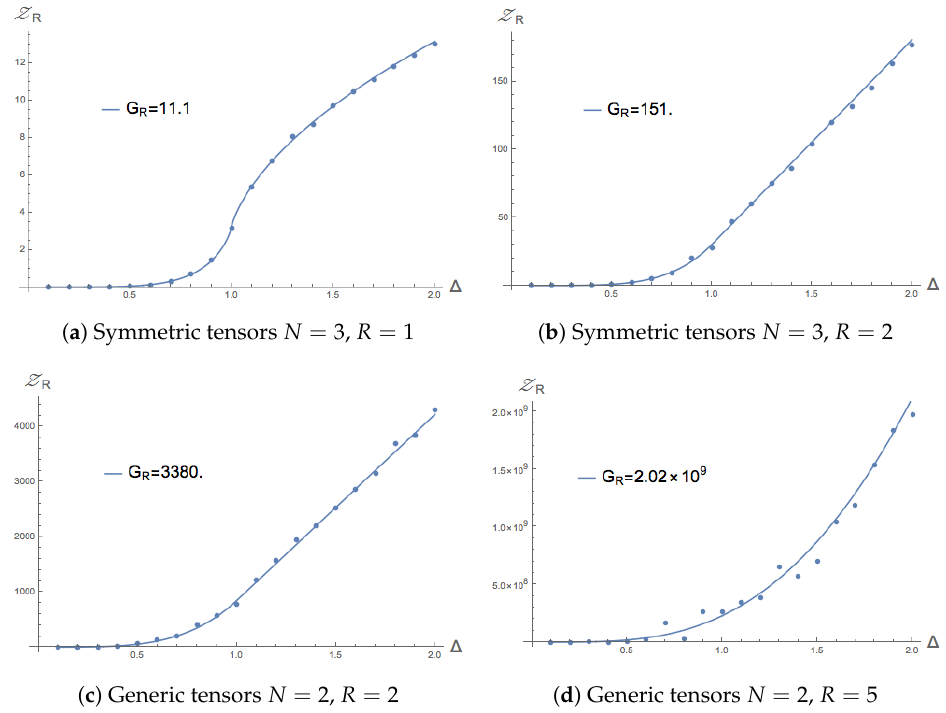
Figure 6. Several examples of the direct numerical evaluation of Z R ( ∆ ) for K = 3 and w = 1 as a function of ∆ . The dots illustrate the numerically evaluated values, while the line is the curve in (22) with the value of G R determined numerically as explained in Section 4.